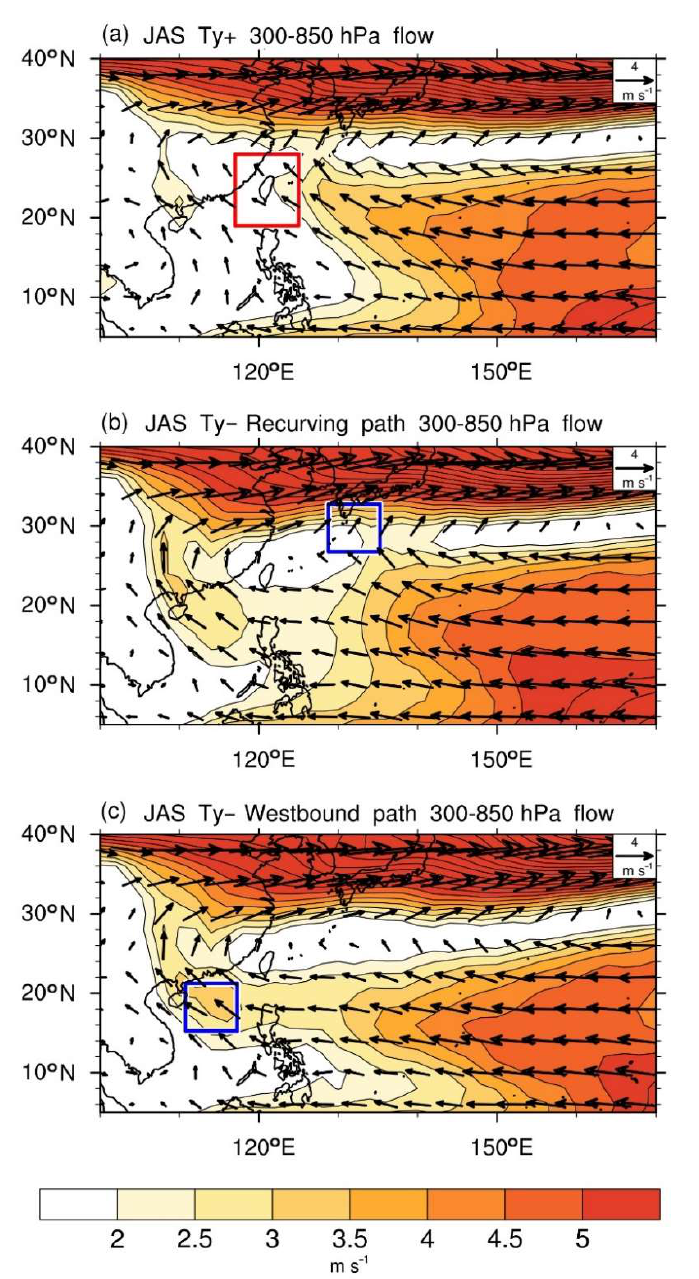
Figure 5. The steering flow averaged from 300 hPa to 850 hPa shown by vectors and wind speed (unit: m s − 1 ) for ( a ) the Ty + category, ( b ) the recurving path of the Ty − category, and ( c ) the westbound path of the Ty − category. The red box in ( a ) shows the typhoon verification domain A, and the blue boxes in ( b ) and ( c ) show the verification domains B and C for typhoon path categorization.